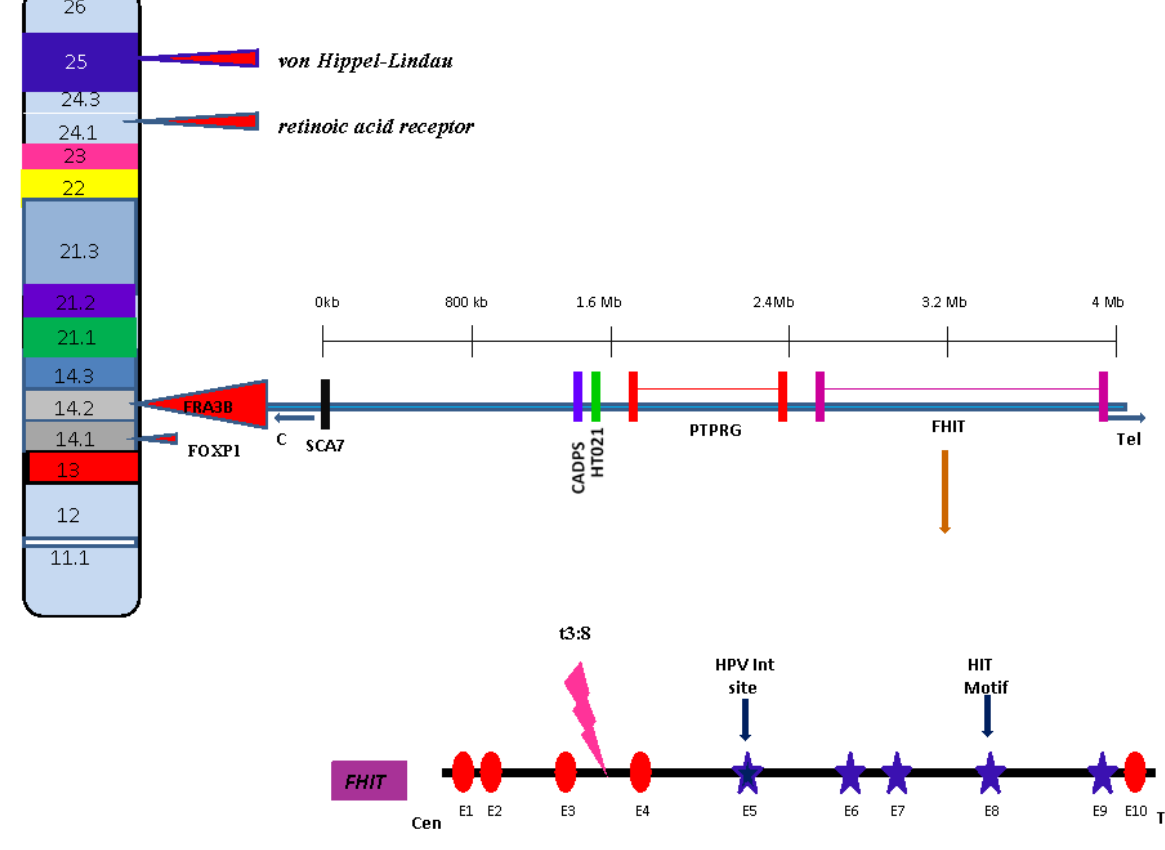
FIGURE 1 . Chromosome 3p contains multiple numbers of potential tumor-suppressor genes, such as VHL, RAR, FOXP1, FHIT , etc. The short arm of chromosome 3 also contains a fragile site known as FRA3B at the 14.2 locus, which holds five genes depicted by solid-colored lines [Sca7 (black), CADPS (blue), HT021 (green), PTPRG (red), and FHIT gene (pink)]. Directions of centromere and telomere are shown with arrows. The FHIT gene is composed of 10 exons, out of which five are coding exons. Exons E1, E2, E3, E4, and E10, depicted by , are untranslated exons and exons E5, E6, E7, E8, and E9, depicted by , are translated exons. The t(3;8) translocation is situated between exons 3 and 4. The HPV integration site is present in exon 5 and the histidine triad residue is located in exon 8.